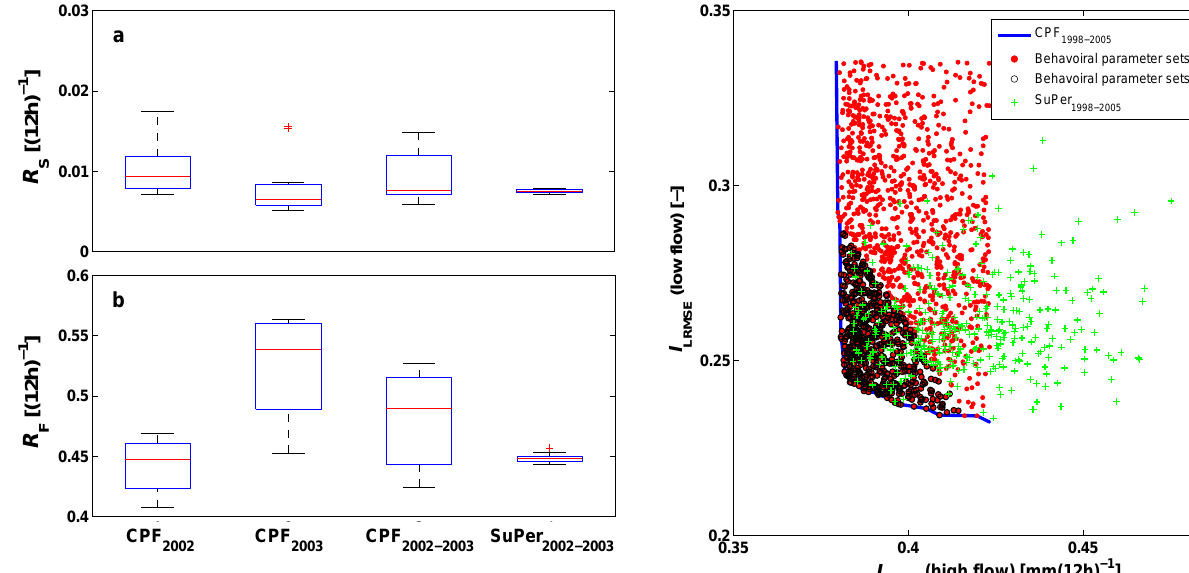
Fig. 6. Parameter distributions of Pareto members of 2002, 2003 and 2002–2003 (CPF2002, CPF2003, CPF2002–2003) and SuPer cali- bration (MDPF2002–2003) for (a) slow reservoir coefficient ( R S ) and (b) fast reservoir coefficient ( R F ). Whiskers represent the 1.5 times the interquartile range (IQR) and the red crosses show out- liers.